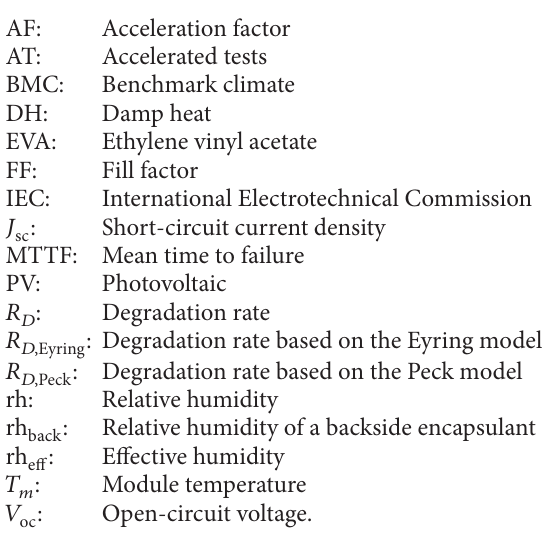
Figure 7: Normalized 𝑅 𝐷 exposure to actual weather conditions for 1 year and AF of accelerated conditions: (a) normalized 𝑅 𝐷, 𝑅 𝐷, Peck for an initially dry module after exposure to two BMCs, (b) AF exposure to 85 Miami (FL,